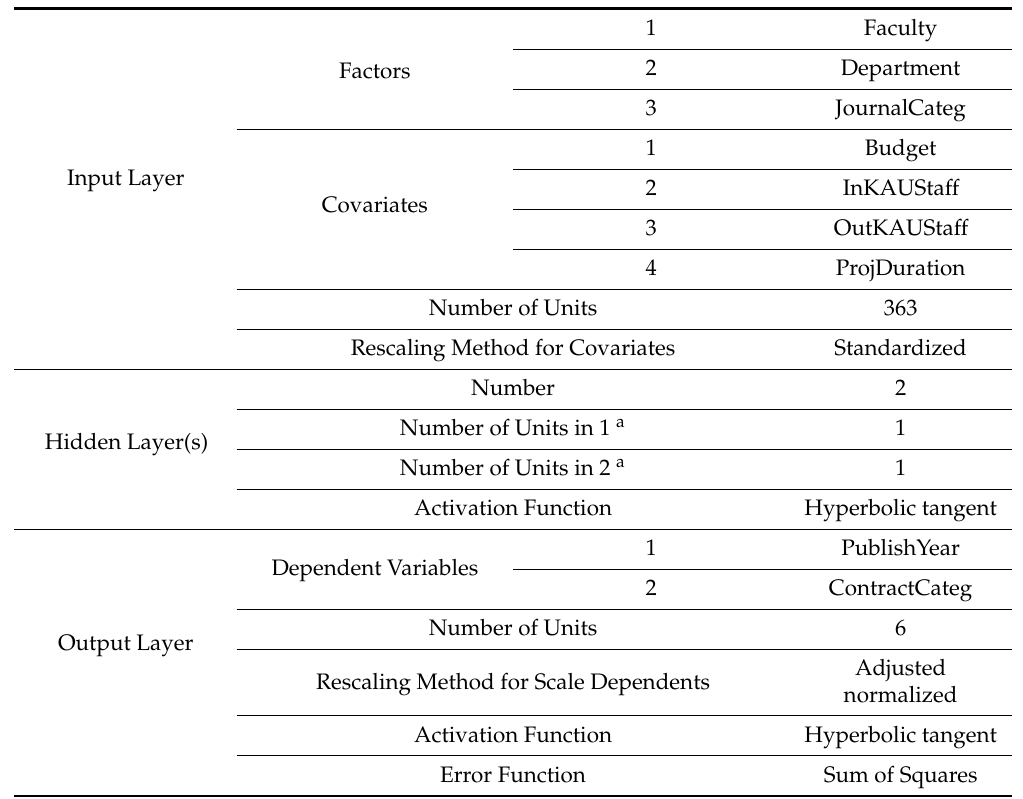
Table 2. Multilayer perceptron (MLP) artificial neural network (ANN)